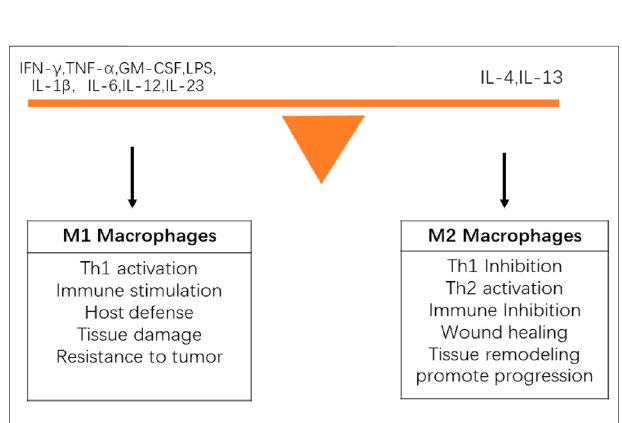
FIGURE 3 | Characteristics of M1 and M2